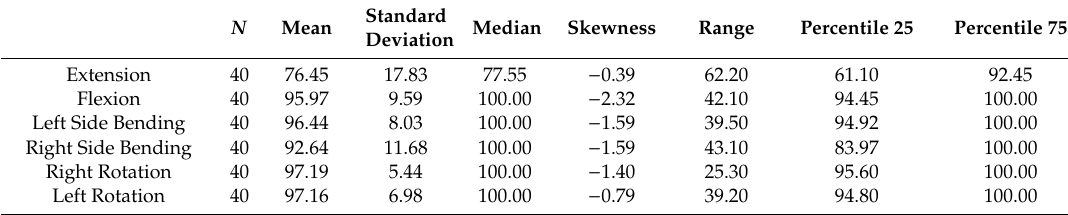
Table 4. Control group normalized values of ROM using Swinkels guidelines.